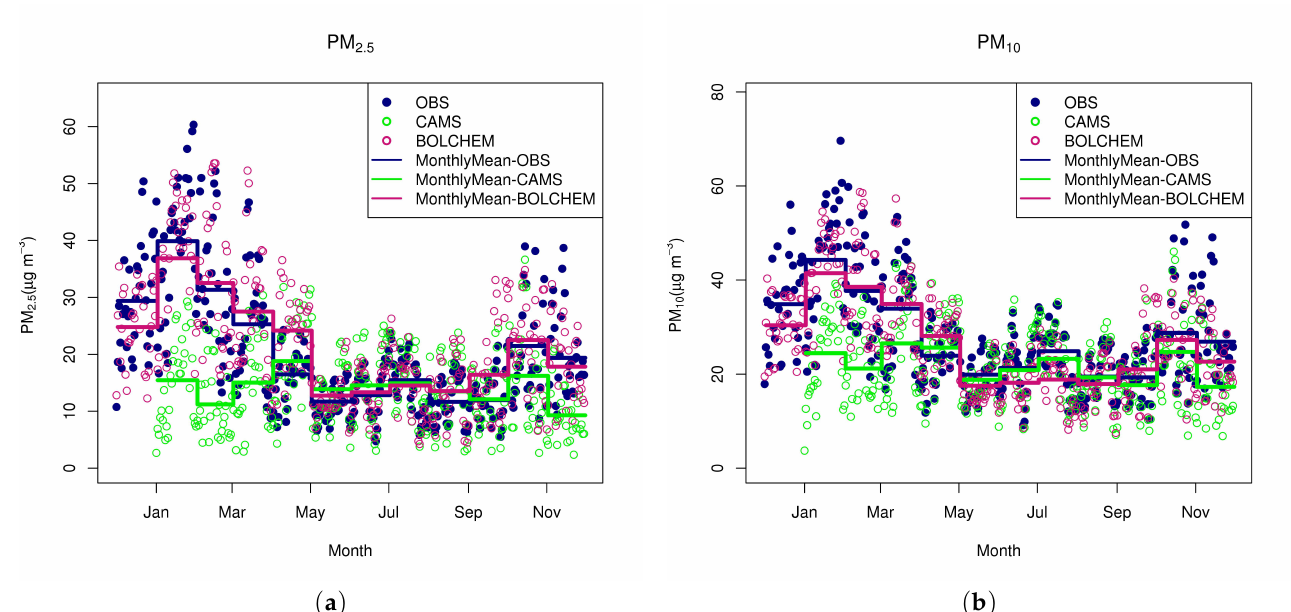
Figure 15. As in Figure 14, but for PM 2.5 ( a ) and PM 10 ( b ) daily mean values concentration ( µ g m − 3 ).